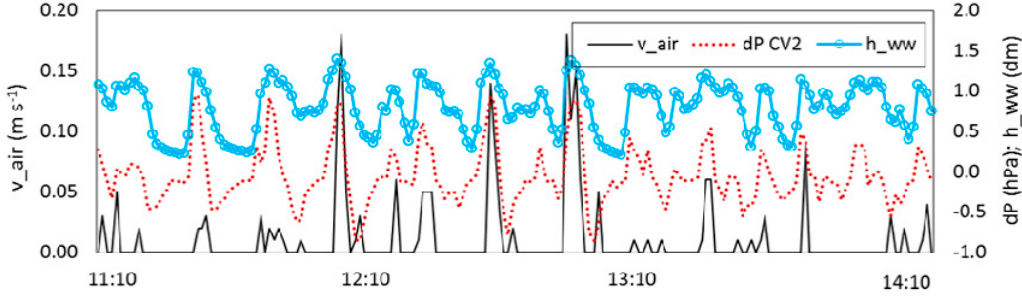
Figure 4. Variation of pressure differences between manhole invert and ambient atmosphere, air velocity and wastewater depth at pipe invert at C-2, during 07.06.2018 (M2 setup). Figure 5 depicts the variation of headspace parameters over time at three monitored locations (venting stack, C-2, and C-5) during a period of roughly 4.5 h. Passage from baseline conditions to one open manhole at C-2 at 12:25 pm is indicated with a dashed red line. For a clearer visualization of longer term trends, a 10 min moving average (darker shading line) was calculated and added to each chart over the monitored data (lighter shading line).